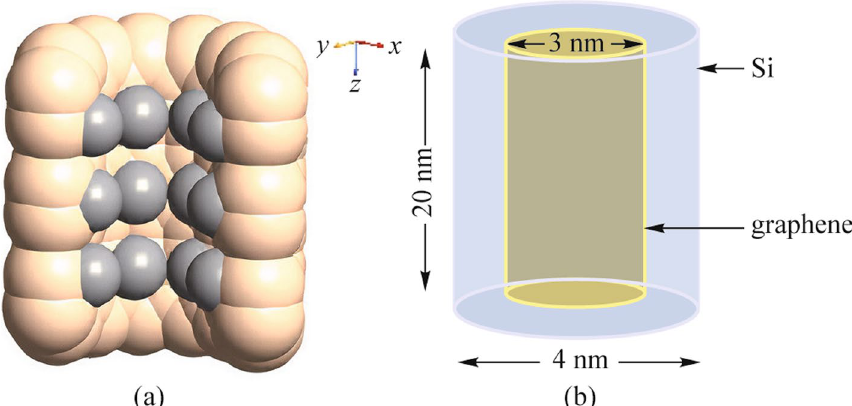
Fig. 1 a Atomistic structure of the graphene/Si QD; b schematic structure of the graphene/Si QD